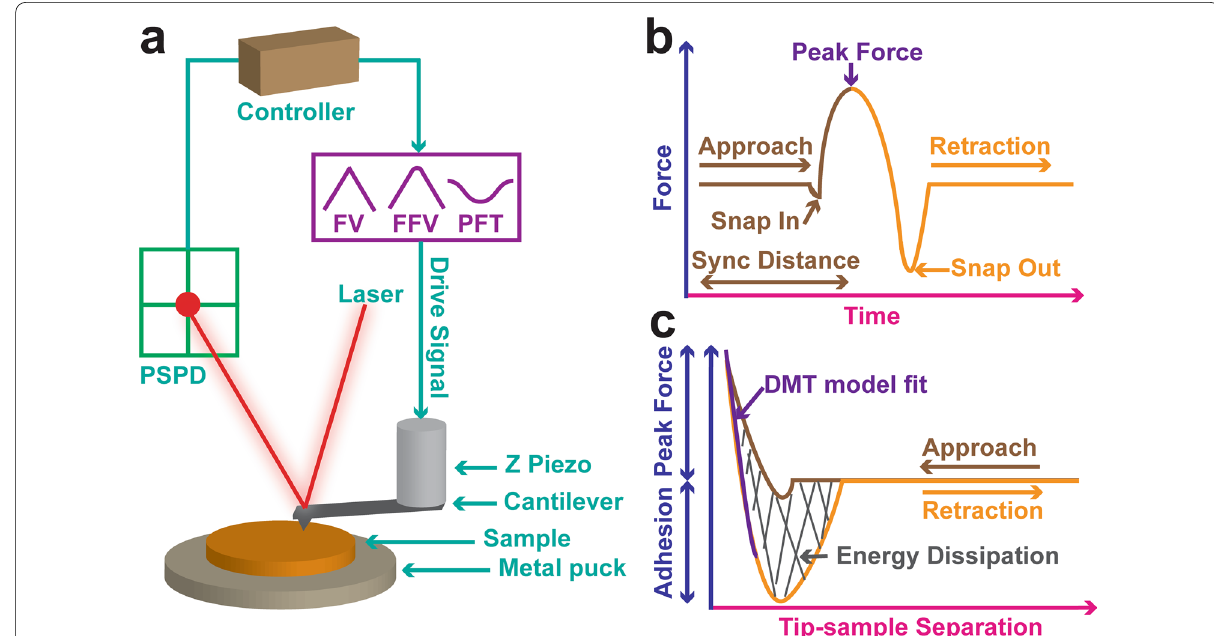
Fig. 1 Mechanism of AFM force ramp, experimental design, data acquisition and interpretation. The LDPE sample was mounted onto a metal puck. A sharp cantilever tip indented into the LDPE sample and retracted away when a preset applied force was reached ( a ). A laser shined from the top, hit and deflected off from the back side of the cantilever. The deflection signal was received by a position sensitive photodiode (PSPD). The cantilever motion was driven by the attached Z piezo. Depending on the choice of technique, the drive signal could be a triangular wave (FV), a corner-rounded triangular wave (FFV) or a sine wave (PFQNM). The PFQNM force measurement was schematically depicted in b , Force versus time plot clearly illustrated the tip underwent a snap-in contact when brought close the sample surface and a snap-out of contact when retracted away from the sample surface. The Sync Distance was a time constant at which the height sensor reached the lowest position. The force versus Z displacement curve (F-Z) was recorded by the AFM and further converted into the force versus tip-sample separation (F-D) curve ( c ). The DMT modulus was extracted by fitting the contact part of retraction curve with DMT model. The integration over the hysteresis loop was referred to